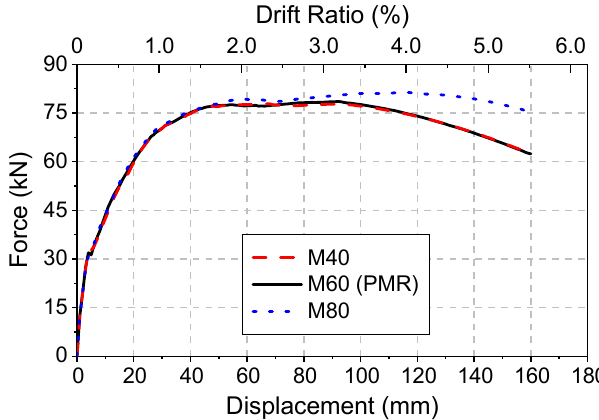
Figure 29. Force–displacement relation with different mortar grades.